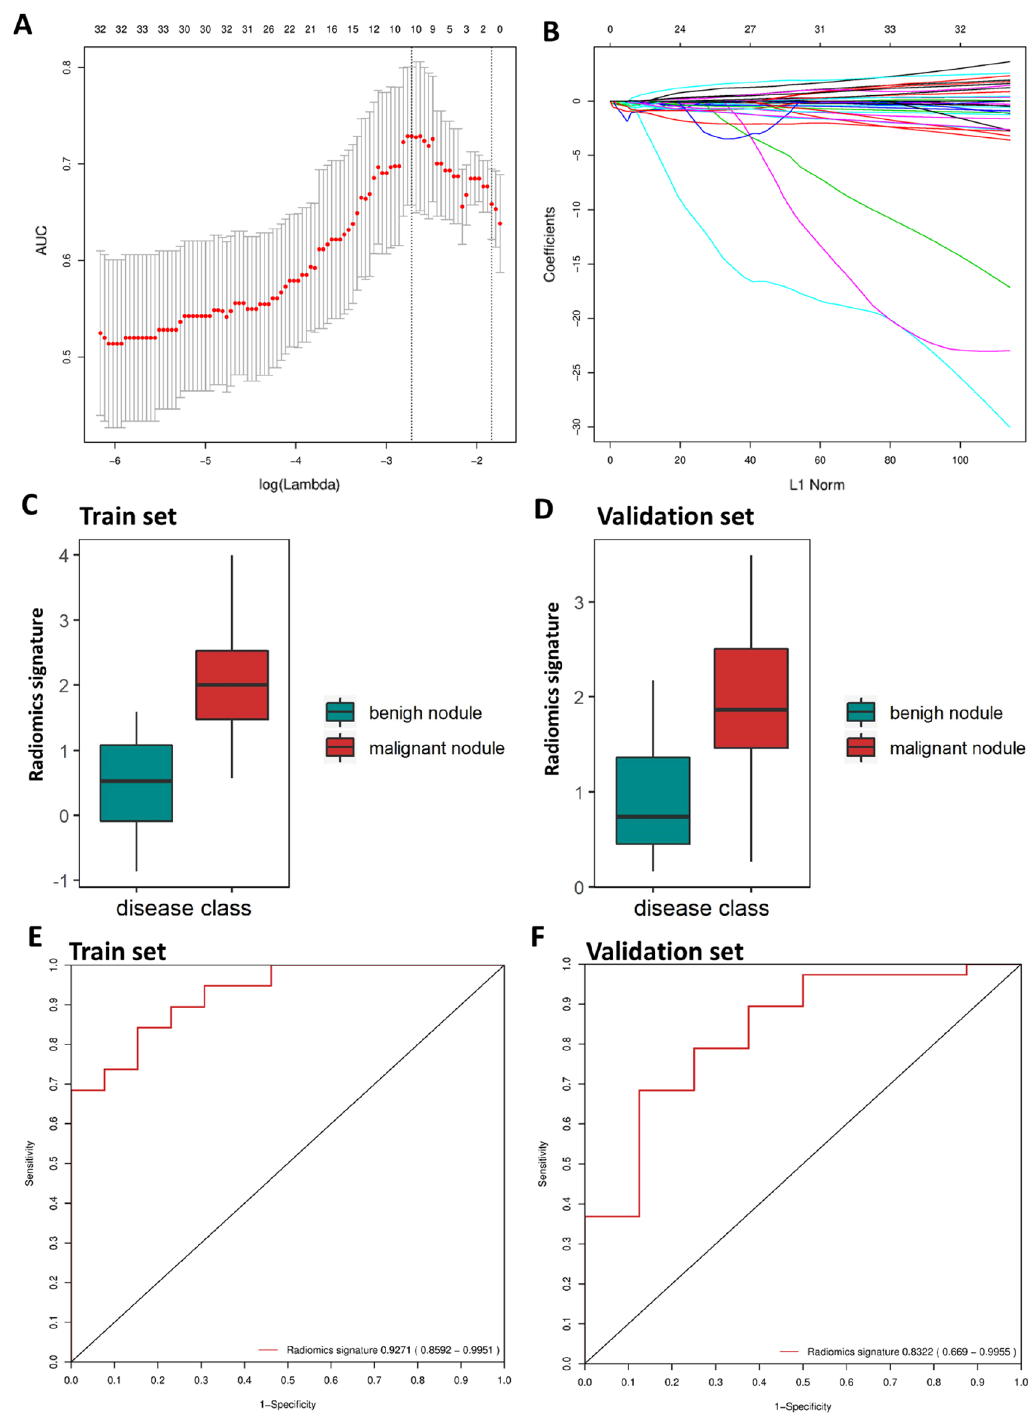
Figure 2. Texture feature selection using LASSO logistic regression and predictive accuracy of the radiomics signature. ( A ) Selection of the tuning parameter (λ) in the LASSO model via fivefold cross-validation based on maximum criteria. The predicted AUC from the LASSO regression cross-validation procedure was plotted as a function of log(λ). The y-axis indicates the predicted AUC. The lower x-axis indicates the log(λ). Numbers along the upper x-axis represent the average number of predictors. Red dots indicate the average predicted AUC for each model with a given λ, and vertical bars through the red dots show the upper and lower values of the predicted AUC. The vertical black lines define the optimal values of l, where the model provides its best fit to the data. An optimal λ value of 0.066 with log(λ) = −2.72 was selected. ( B ) LASSO coefficient profiles of the 788 texture features. The dotted vertical line was plotted at the value selected using fivefold cross-validation in A. The ten resulting features with nonzero coefficients are indicated in the plot. Plots ( C ) and ( D ) present the boxplots of the radiomics score in the training and validation sets, respectively. Plots ( E ) and ( F ) show the receiver operating characteristic (ROC) curves of the radiomics signature in the training and validation sets,